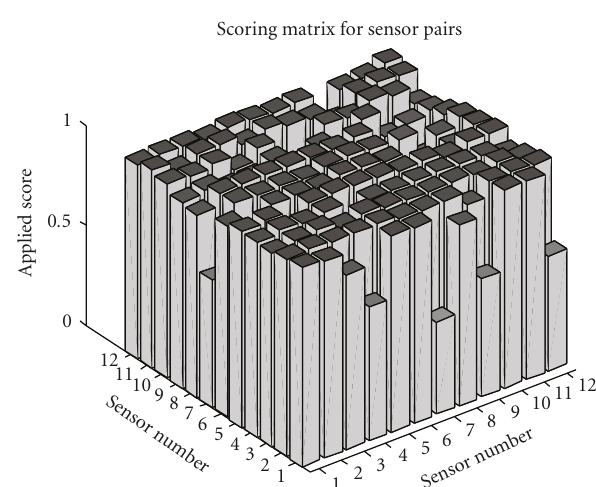
Figure 12: Scoring matrix derived from standard deviation of range estimates.